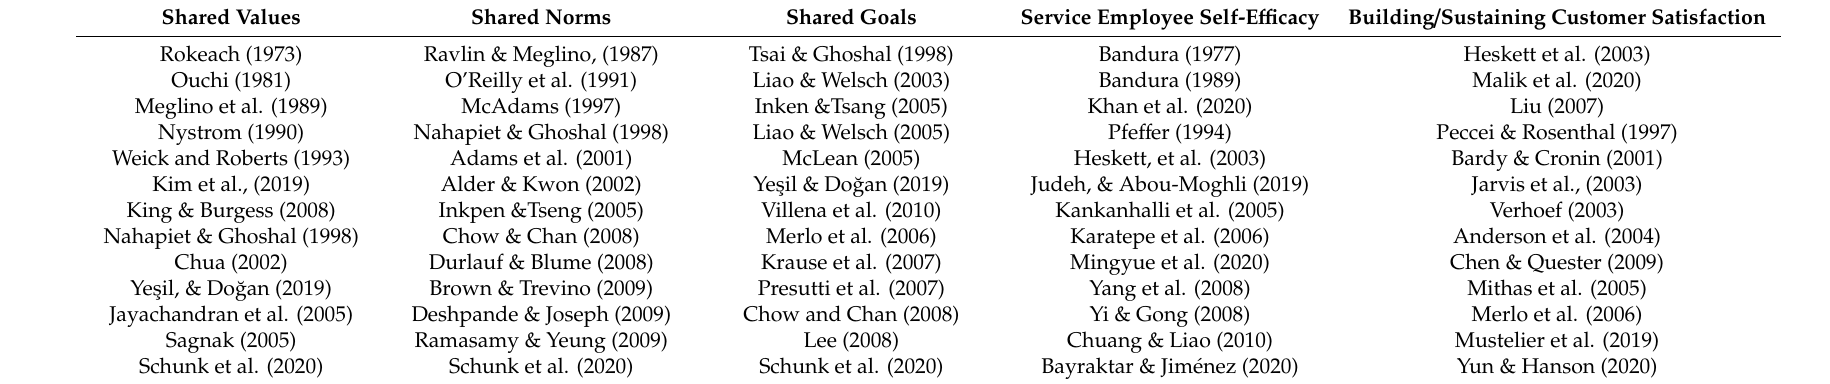
Table A1. Key Studies Related to this Study’s Constructs.